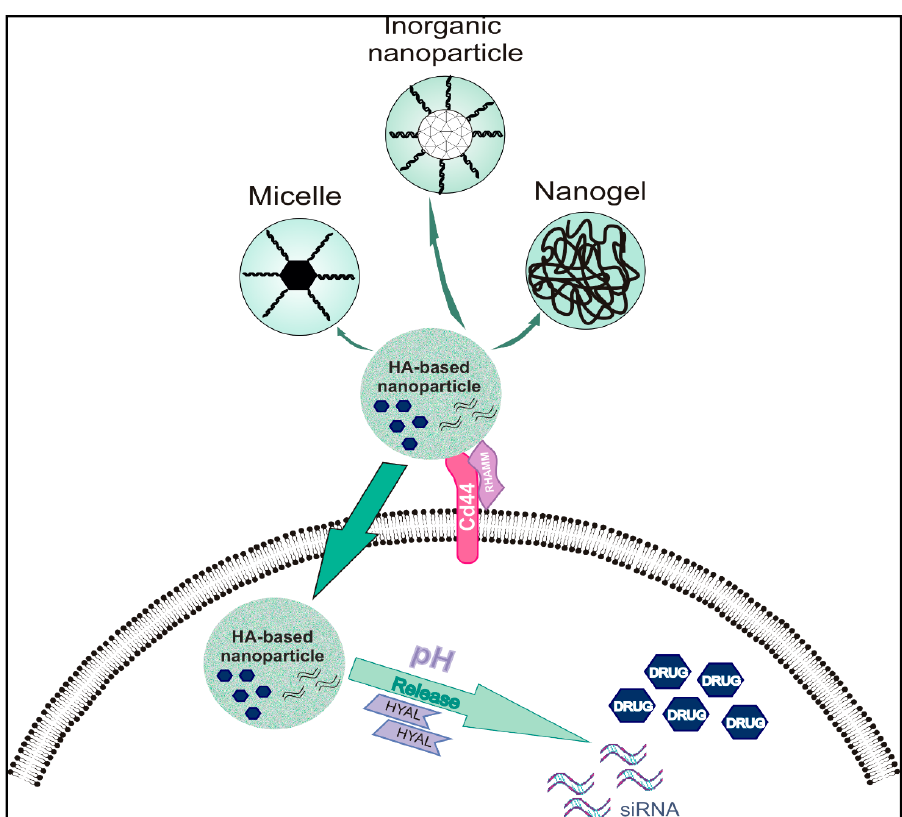
Figure 1. Mechanism of action of HA-based nanoparticles: HA (Hyaluronic acid)-based nanomedicines are used to medi- ate targeted delivery of therapeutic compounds (DRUGS or siRNA: small interfering RNA) in cancer cells. Nanoparticle targeting is enhanced by HA-specific interaction with CD44 or RHAMM, which are overexpressed in different cancer cell